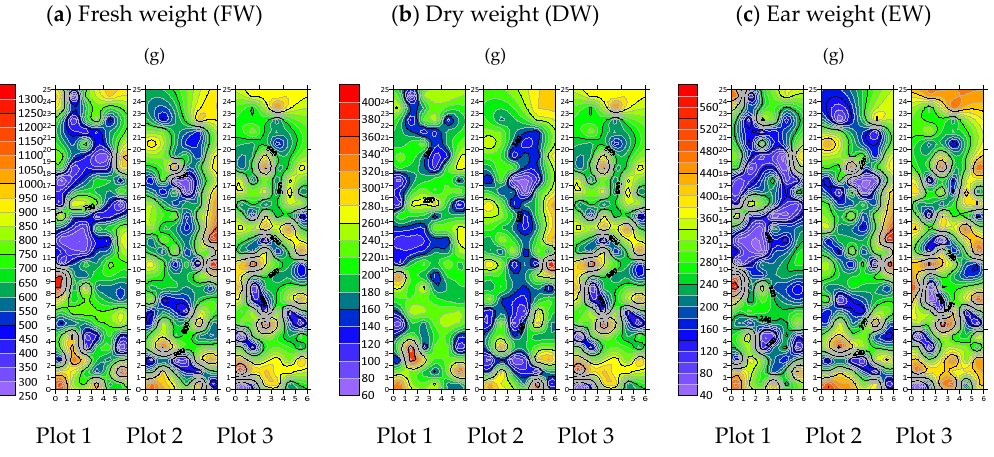
Figure 2. Spatial interpolation using Kriging on the three crop parameters: ( a ) Fresh weight (FW); ( b ) Dry weight (DW); ( c ) Ear weight (EW) of all harvested individual plants.